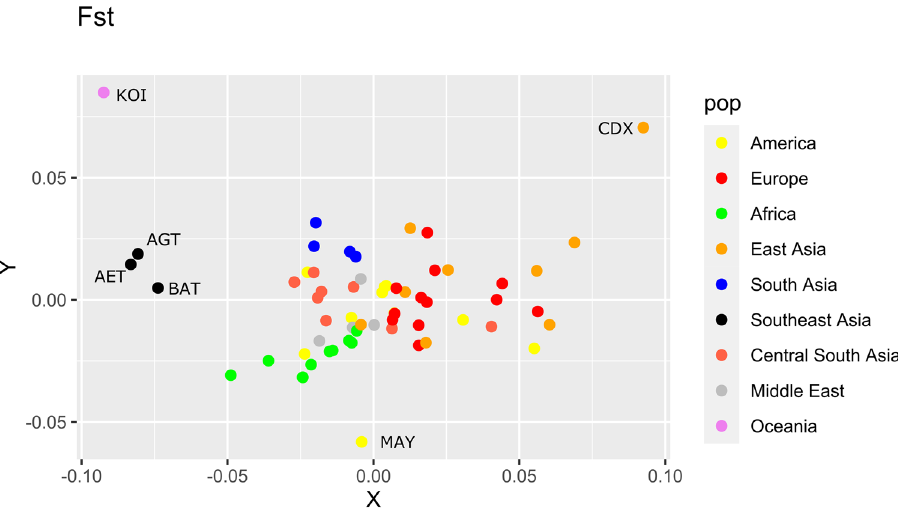
Figure 5. Multidimensional scaling (MDS) illustrating the distance (measured by F ST estimated from HLA-G alleles—coding haplotypes) in populations samples with at least 10 individuals. The name of each population is available at Table S1. We have indicated the names of some